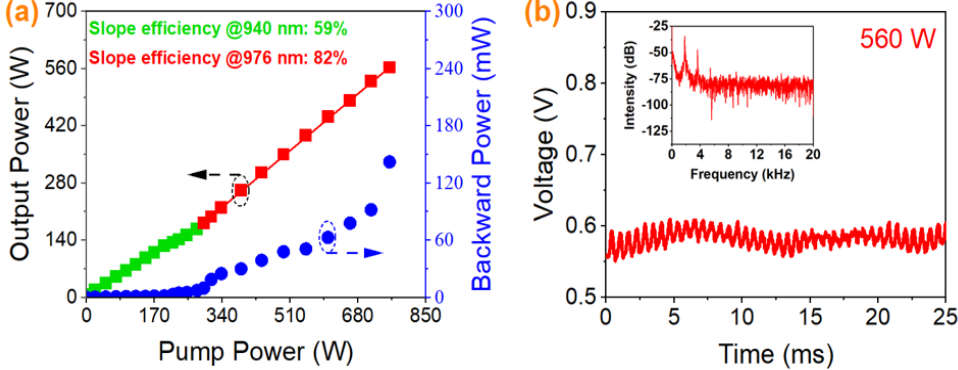
Figure 5. ( a ) Output power and backward propagating power versus pump power. ( b ) Signals in temporal intensity. Inset: corresponding Fourier spectra at 560 W.